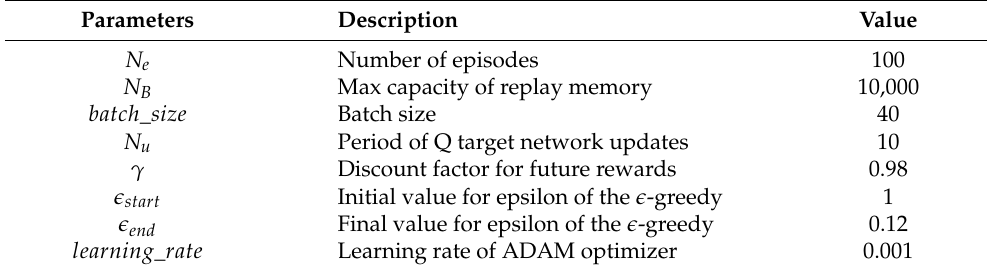
Table 2. Parameters for training the AI agent.